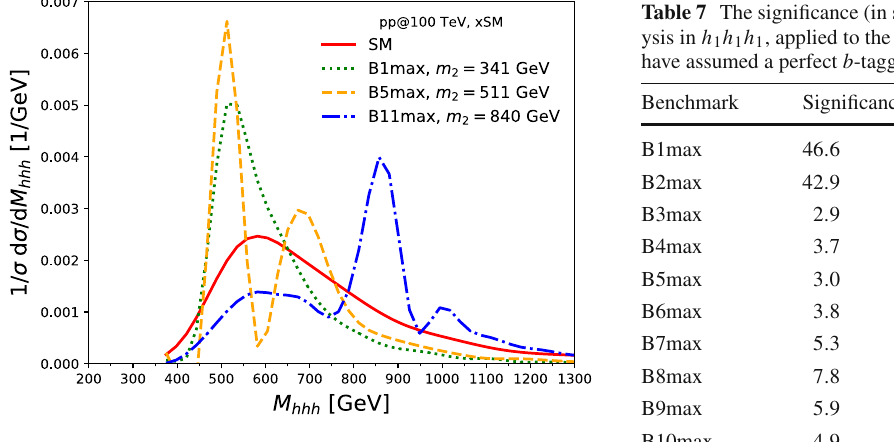
Fig. 8 The (normalised) invariant mass distribution of the three Higgs boson system in triple h 1 production within the xSM at the FCC-hh at 100TeV,reconstructedfromMonteCarlotruthwithnocutsapplied.We show three benchmark points from [44], as well as the SM expectation for comparison